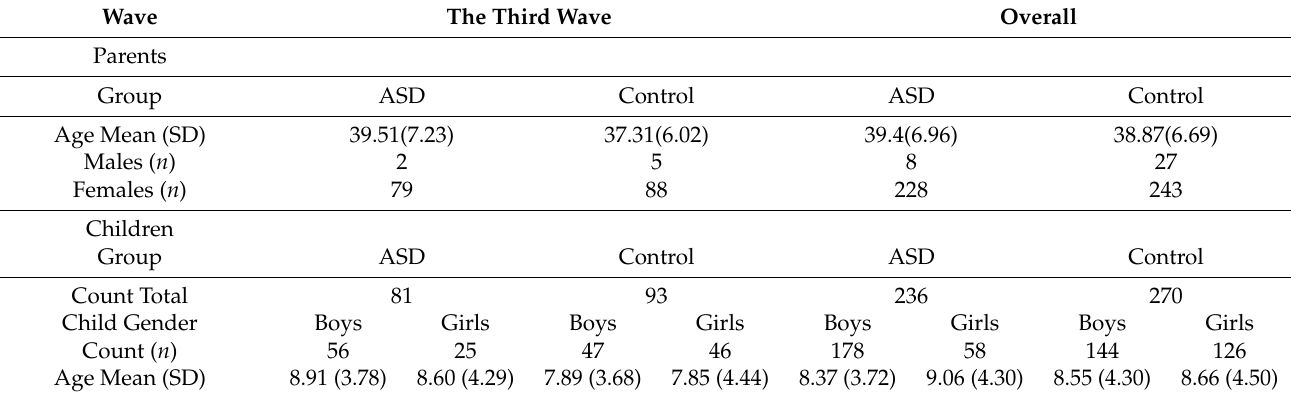
Table 1. Demographic characteristics of our sample recruited during the third COVID-19 pandemic wave and in